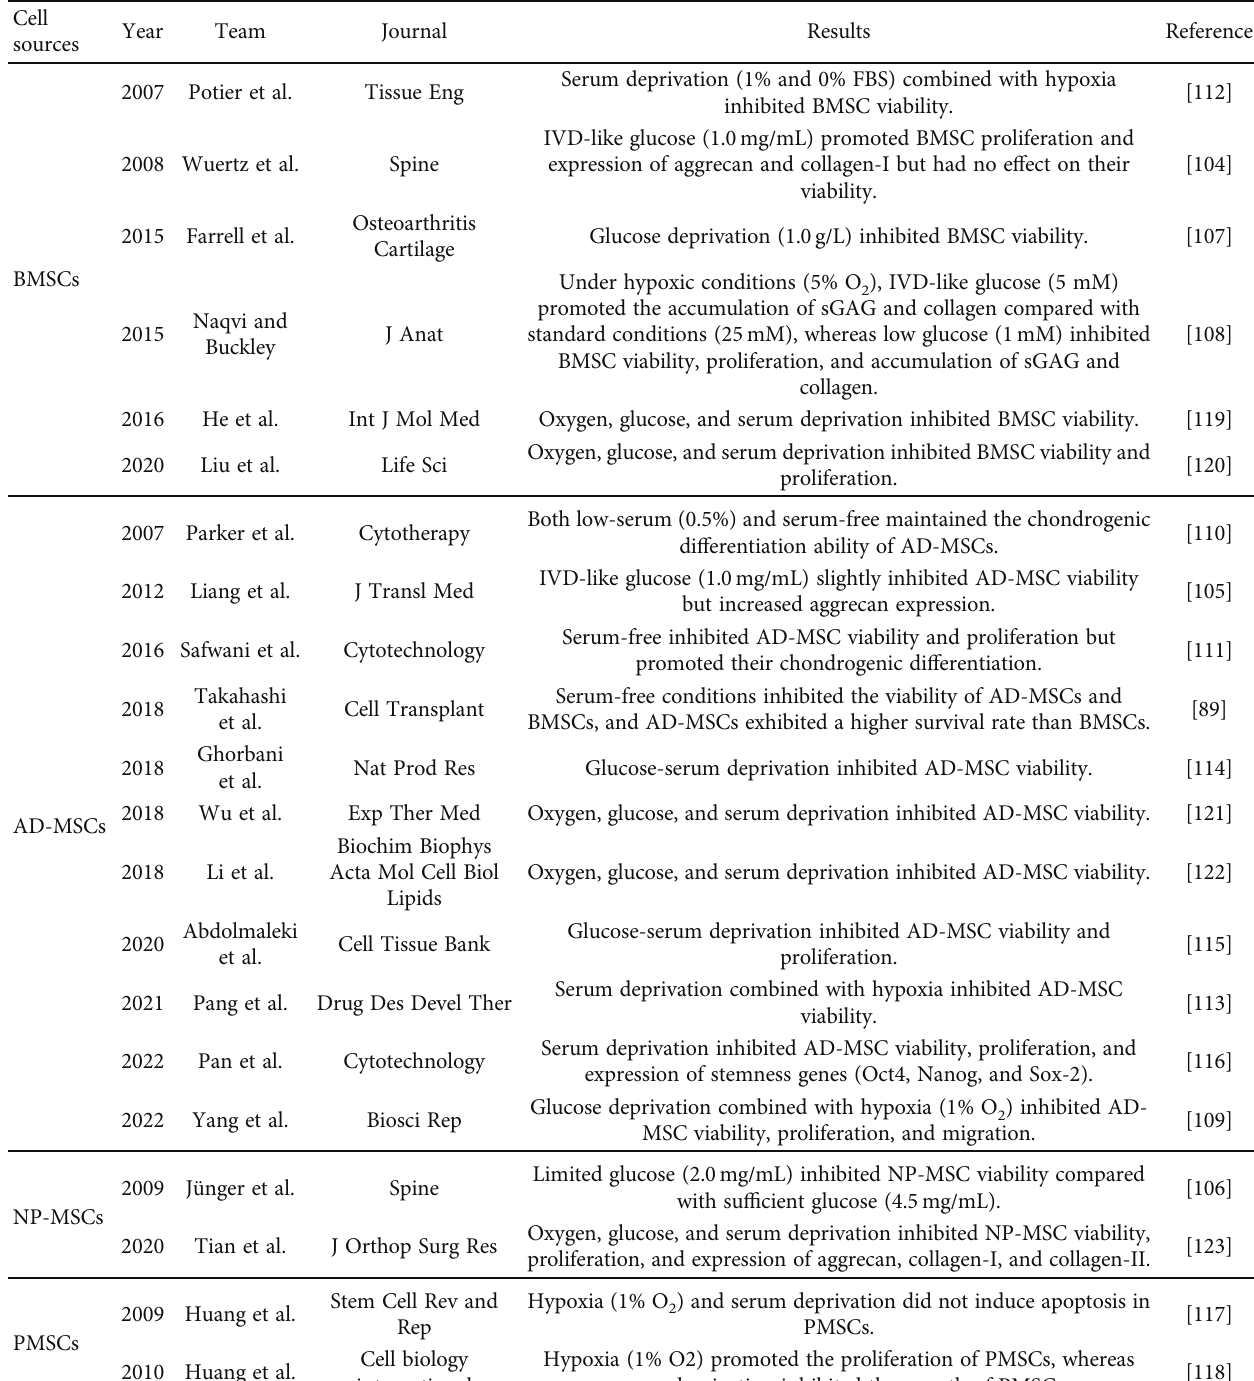
Table 3: E ff ects of nutrient de fi ciency on the biological behavior of